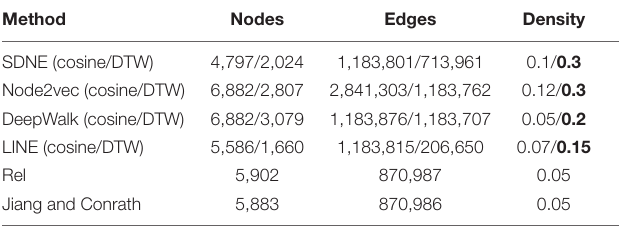
TABLE 4 | AUCPR and AUC values of Human protein similarity prediction (the top 5% of the similarity network).